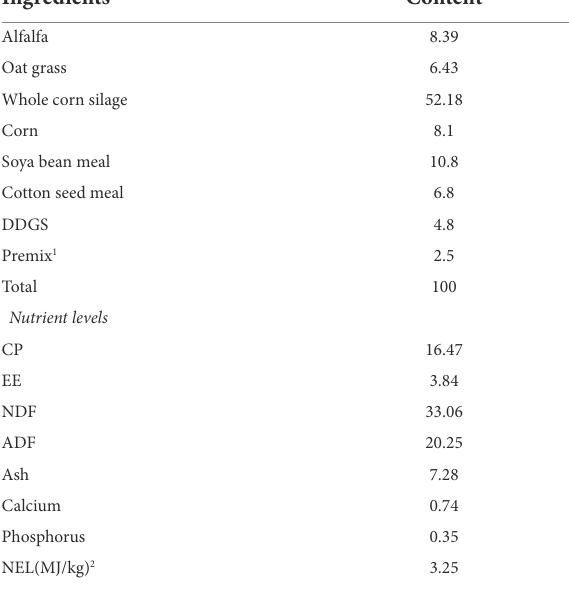
TABLE 1 Composition and nutrient levels of the experiment diet [dry matter (DM) basis %].